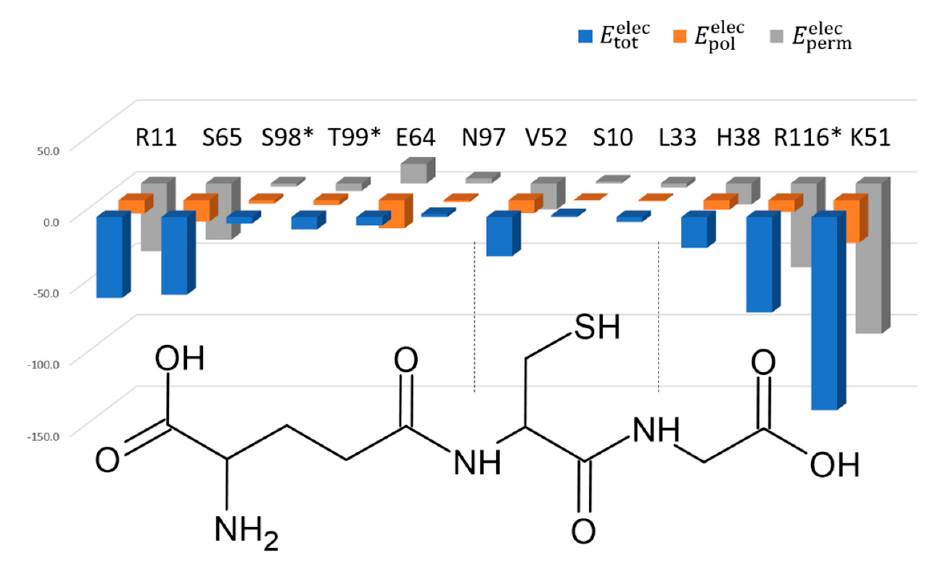
Figure 4. Permanent, polarization and total electrostatic interaction energies. The permanent (cid:1831) (cid:2926)(cid:2915)(cid:2928)(cid:2923) (cid:2915)(cid:2922)(cid:2915)(cid:2913) , polarization (cid:1831) (cid:2926)(cid:2925)(cid:2922)(cid:2915)(cid:2922)(cid:2915)(cid:2913) and total (cid:1831) (cid:2930)(cid:2925)(cid:2930)(cid:2915)(cid:2922)(cid:2915)(cid:2913) electrostatic interaction energies between the glutathione ligand and twelve residues of the SynGSTC1 active site are presented in kcal/mol. (cid:1831) (cid:2926)(cid:2915)(cid:2928)(cid:2923)(cid:2915)(cid:2922)(cid:2915)(cid:2913) is computed using the electron density model transferred on the glutathione and the protein atoms, whereas (cid:1831) (cid:3047)(cid:3042)(cid:3047)(cid:3032)(cid:3039)(cid:3032)(cid:3030) is obtained after the electron density polarization procedure. Finally, (cid:1831) (cid:2926)(cid:2925)(cid:2922)(cid:2915)(cid:2922)(cid:2915)(cid:2913) is computed using (cid:1831) (cid:2926)(cid:2925)(cid:2922)(cid:2915)(cid:2922)(cid:2915)(cid:2913) = (cid:1831) (cid:3047)(cid:3042)(cid:3047)(cid:3032)(cid:3039)(cid:3032)(cid:3030) − (cid:1831) (cid:2926)(cid:2915)(cid:2928)(cid:2923)(cid:2915)(cid:2922)(cid:2915)(cid:2913) , and represents the polarization contribution to the total electrostatic interaction energy. The reported energy values have been averaged over the two conformations of the glutathione (A and B) observed in the crystal structure and over the two monomers. The GSH formula has been added to highlight the proximity of the residues to the GSH moieties. The residues marked with a star (*) in the figure are not from the same monomer as glutathione. The numerical values of these energies and the associated standard deviations are available in the Supplementary Materials.